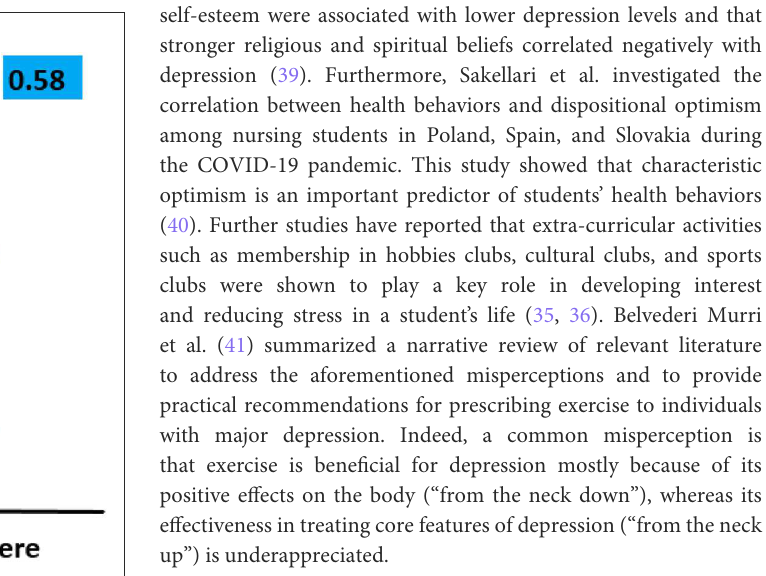
Hence, the emotional dimension of religiosity approaching spirituality would be more crucial than the behavioral